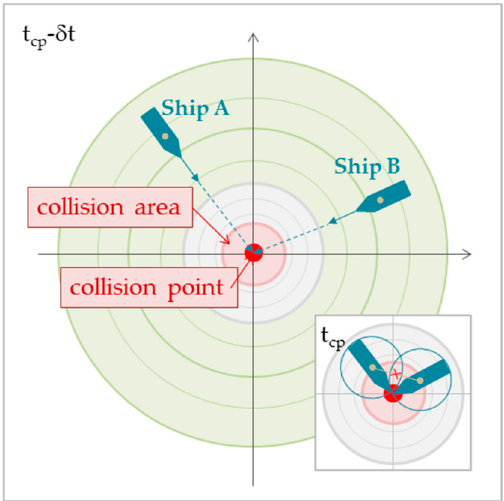
Figure 5. Collision point and area of ships A and B if they follow their planned route and continue their movement (t cp = time of collision, δ t = time span to prevent collision).